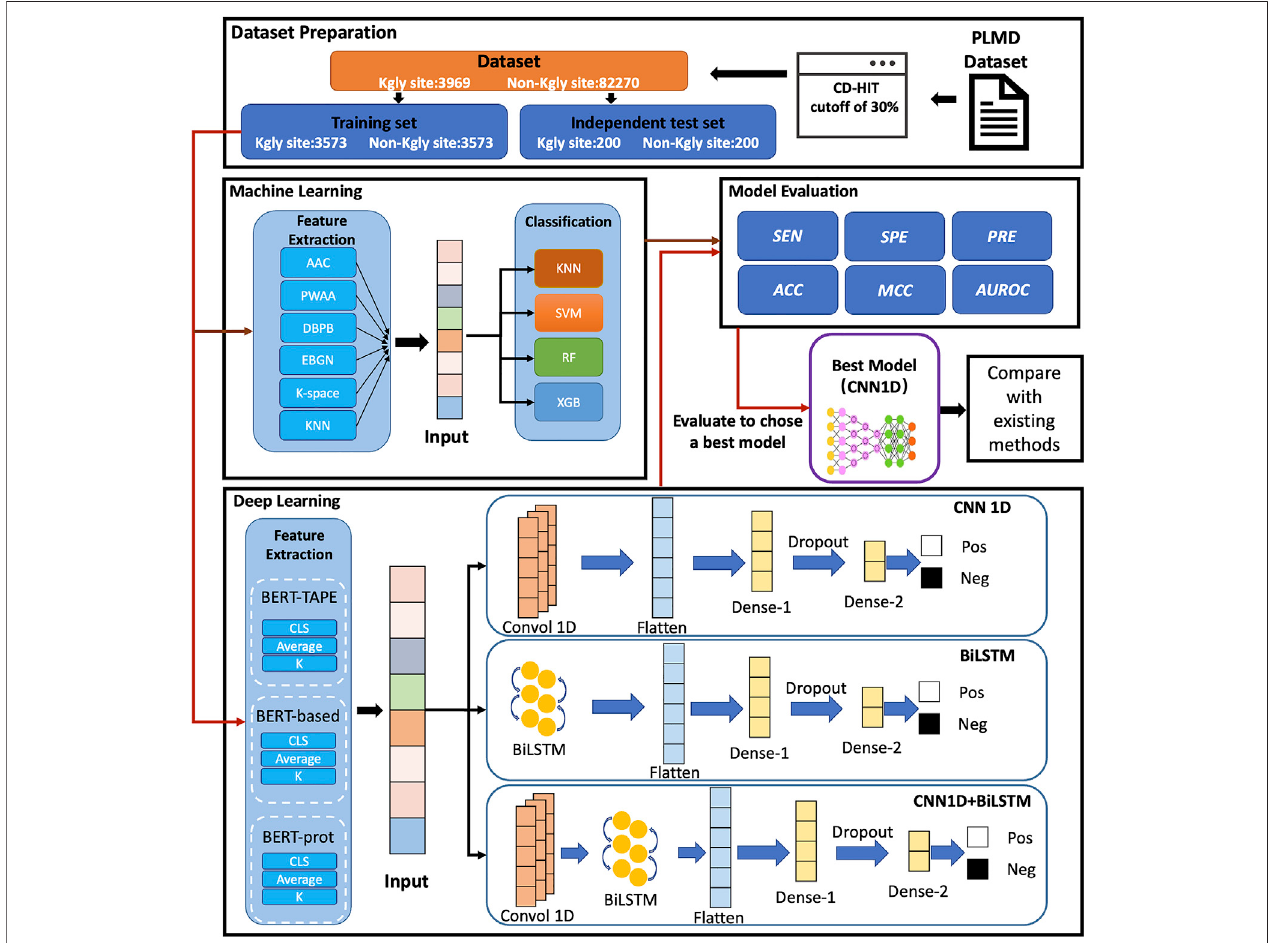
FIGURE 1 | Flowchart for building our